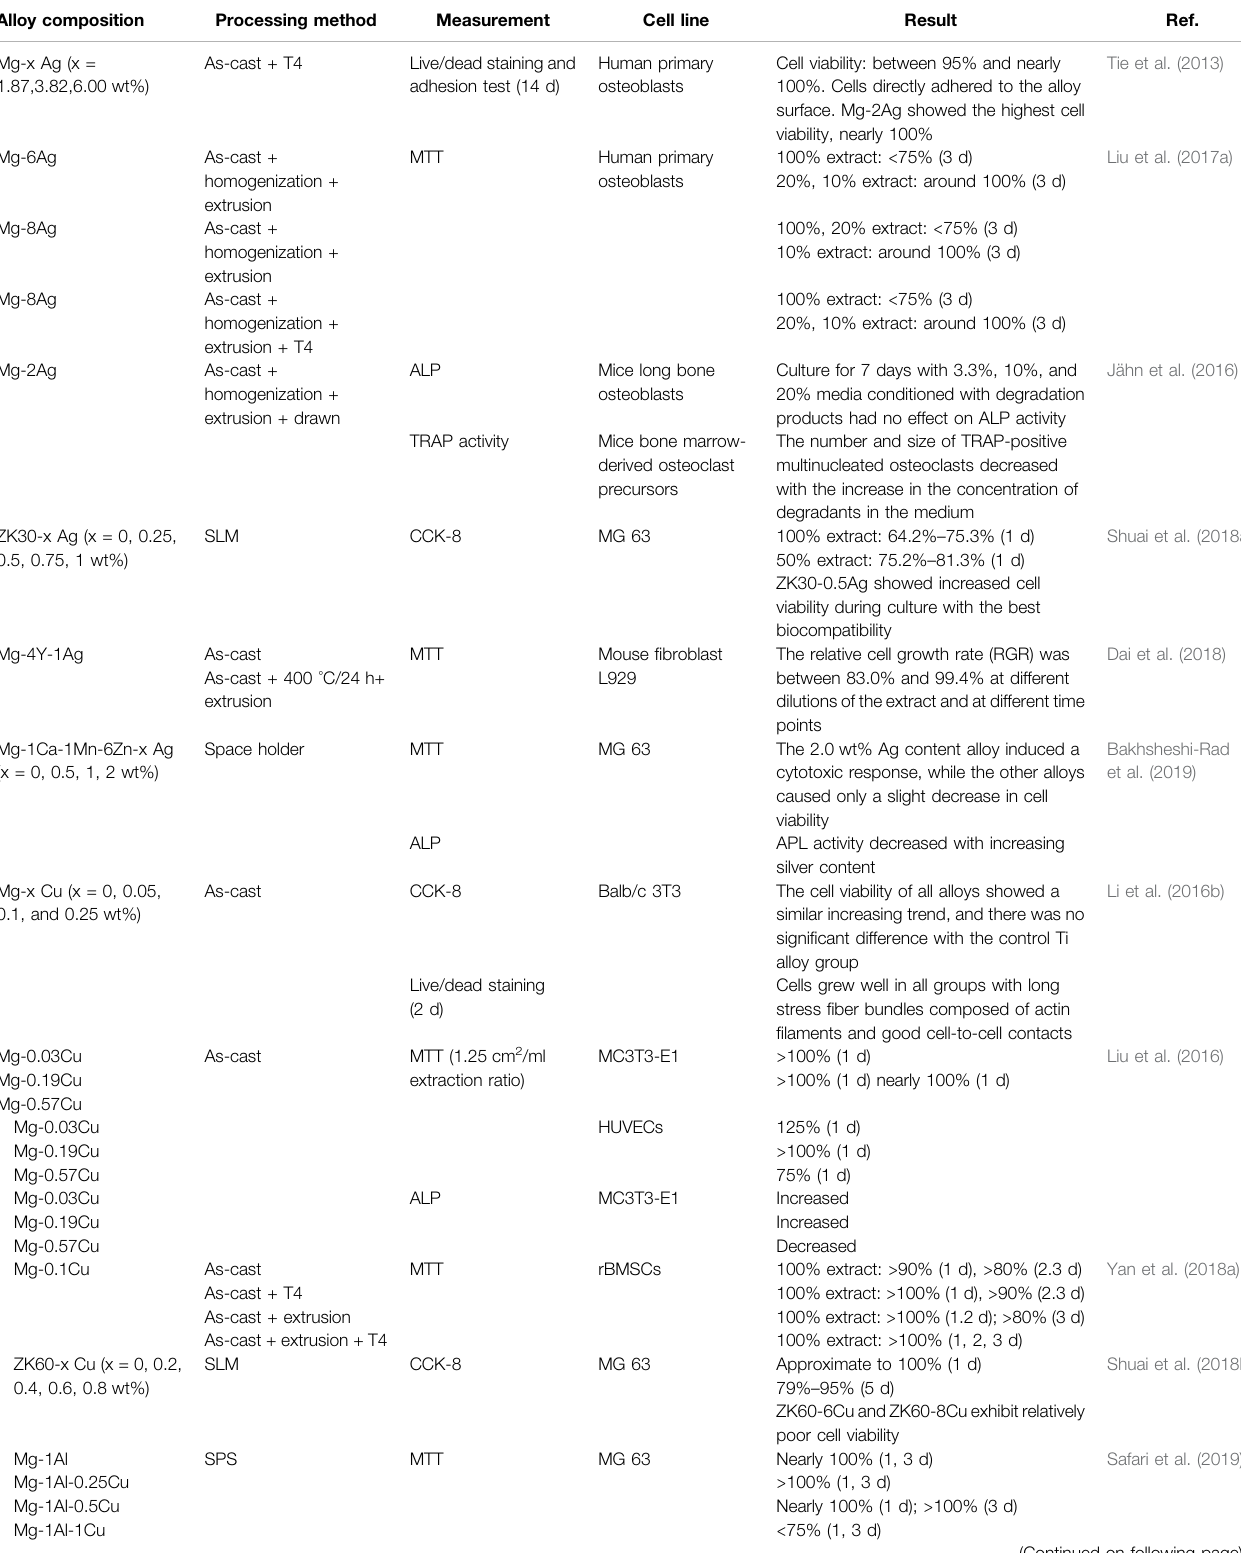
TABLE 4 | In vitro biocompatibility of Mg-based alloys with antibacterial properties as orthopedic